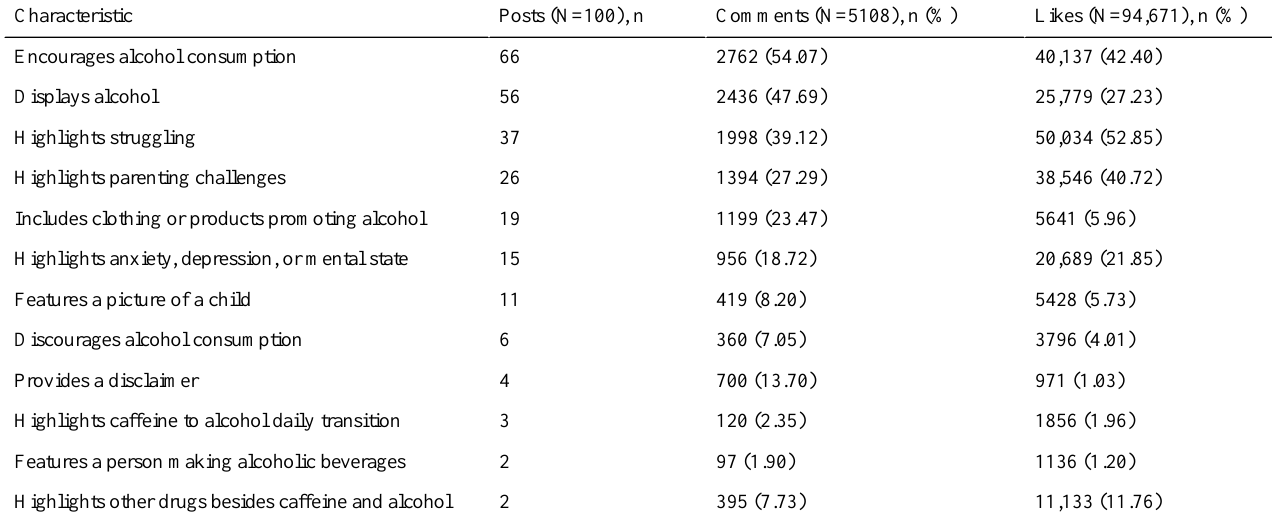
Table 1. Observed content characteristics, comments, and likes of 100 alcohol-related content posted by mothers on